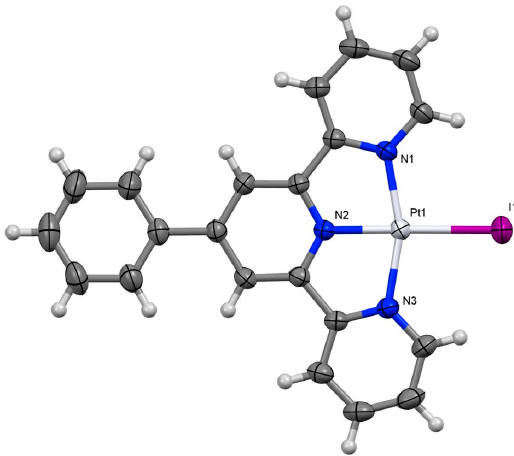
Figure 1. Crystal structure of complex 3 . Thermal ellipsoids are at 50% probability. Main bond distances (Å) Pt1 − N1 2.030(3); Pt1 − N2 1.942(2); Pt1 − N3 2.025(3); Pt1 − I1 2.5834(3). Crystal system: triclinic.